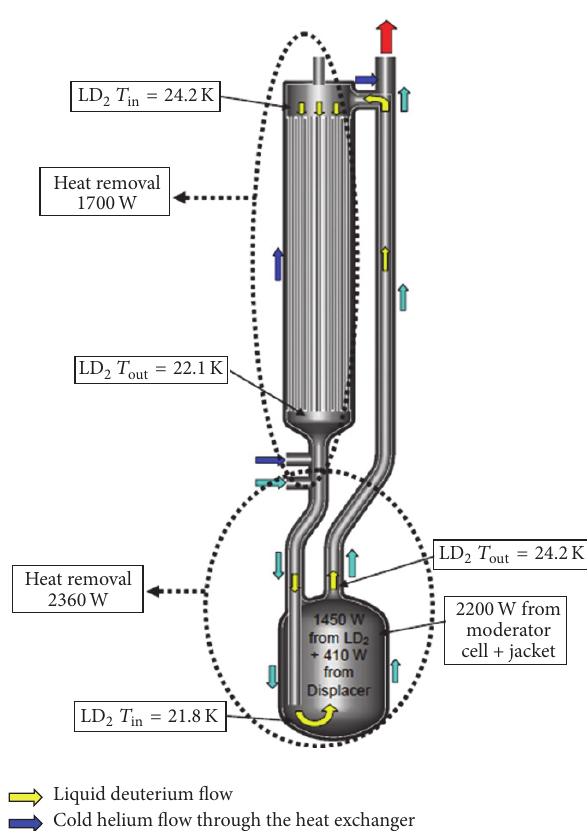
Figure 1: A schematic diagram of the CNS thermosiphon